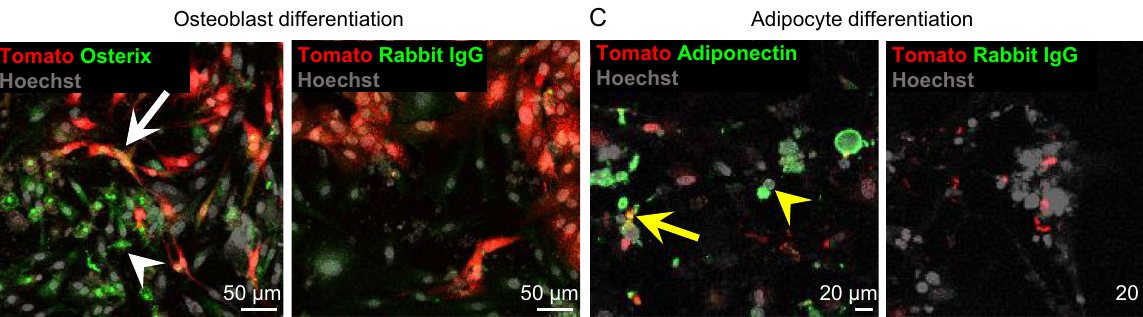
Figure 5. LepR/Tom + PDL cells express stem cell markers, while both LepR/Tom + and LepR/Tom − PDL cells possess in vitro pluripotency. (A) Representative FACS plots (gated on live LepR/Tom + cells) showing the frequency of stem cell marker expression in LepR/Tom + PDL cells; n = 3. Blue and red lines represent isotype controls and antibodies against the stem cell markers indicated, respectively. ( B, C ) Pluripotency of LepR/Tom + and LepR/Tom − PDL cells. Representative images of differentiated osteoblasts ( B ) and adipocytes ( C ) derived from PDL cells of LepR-cre; R26-tdTomato mice; n = 3. Osteoblasts or adipocytes were detected via staining for osterix ( B , green) or adiponectin ( C , green), respectively. Right panels are stained for control rabbit IgG. White arrows: LepR/Tom + /osterix + osteoblasts, white arrowheads: LepR/Tom − /osterix + osteoblasts, yellow arrows: LepR/Tom + /adiponectin + adipocytes, yellow arrowheads: LepR/Tom − /adiponectin + adipocytes. Nuclei were visualized using Hoechst; scale bar = 50 μm ( B ) and 20 μm ( C)